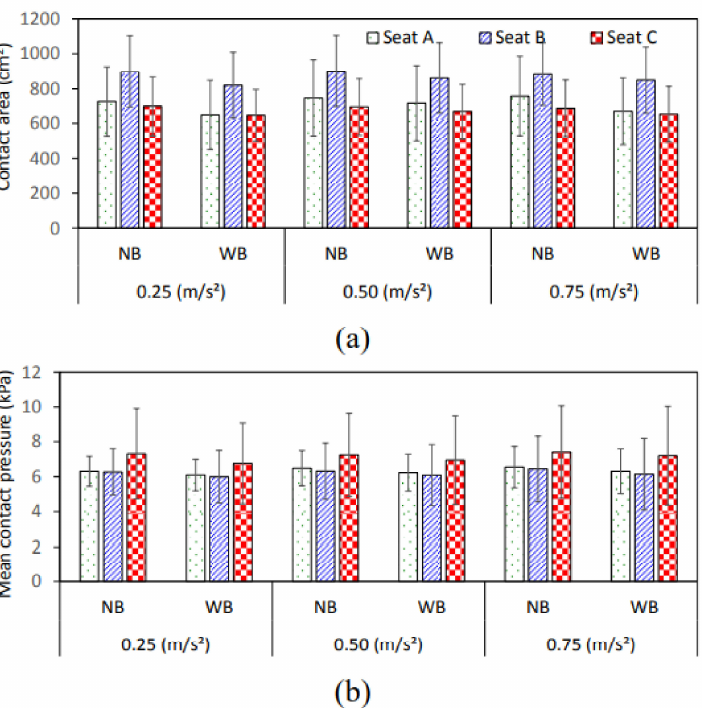
Figure 2. Means and standard deviations (shown as error bars) of: ( a ) contact area; and ( b ) contact pressure measured with 58 participants sitting on different elastic seats with two sitting and three excitation conditions.